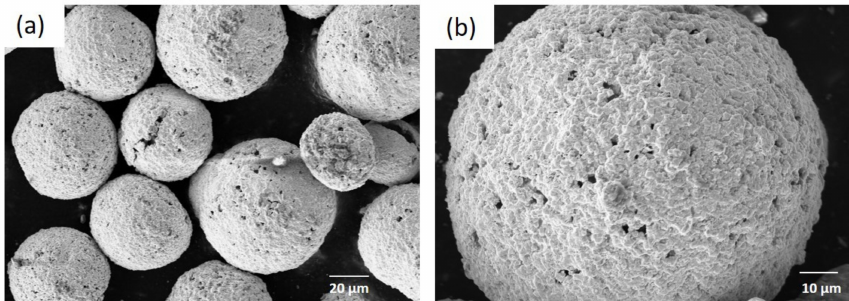
Figure 1. Morphology of WC–12Co powder: low magnification ( a ); high magnification ( b ).